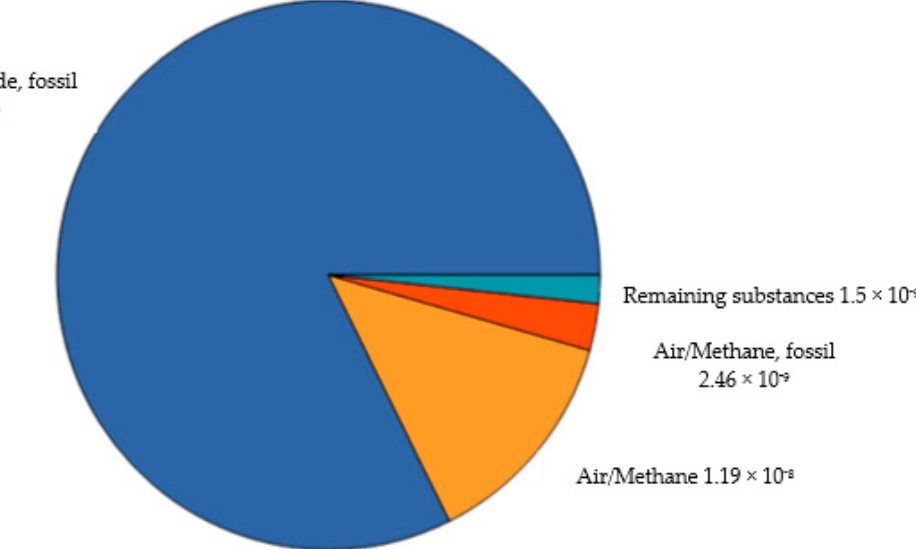
Figure 12. Climate change ecosystem impact assessment of 1 kg of SPF-reinforced sago starch composite takeout food container analyzed (damage assessment/excluding long-term emissions/cut off 1%).